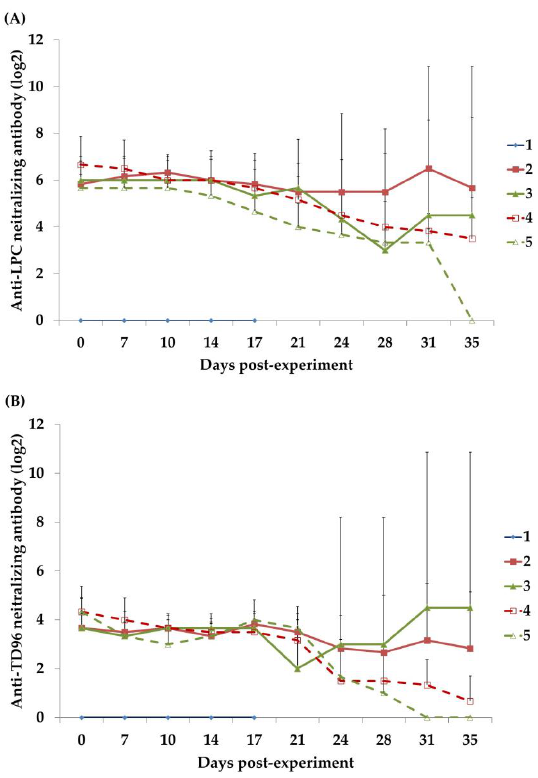
Figure 5. The anti-LPC ( A ) or TD/96 ( B ) NAs in the sera of the piglets in each group during the experimental period. The Group 1 piglet was inoculated oronasally with TD/96 at 7 DPE and served as the CSFV donor (i.e., primary invader), subsequently cohabiting with the piglets of Groups 2 and 3 from 7 to 17 DPE. The Group 2 piglets were LPC vaccinated at 0 DPE, and the Group 3 piglets were not vaccinated with LPC. The piglets in Groups 4 and 5 cohabited with those in Groups 2 and 3, respectively, from 17 to 35